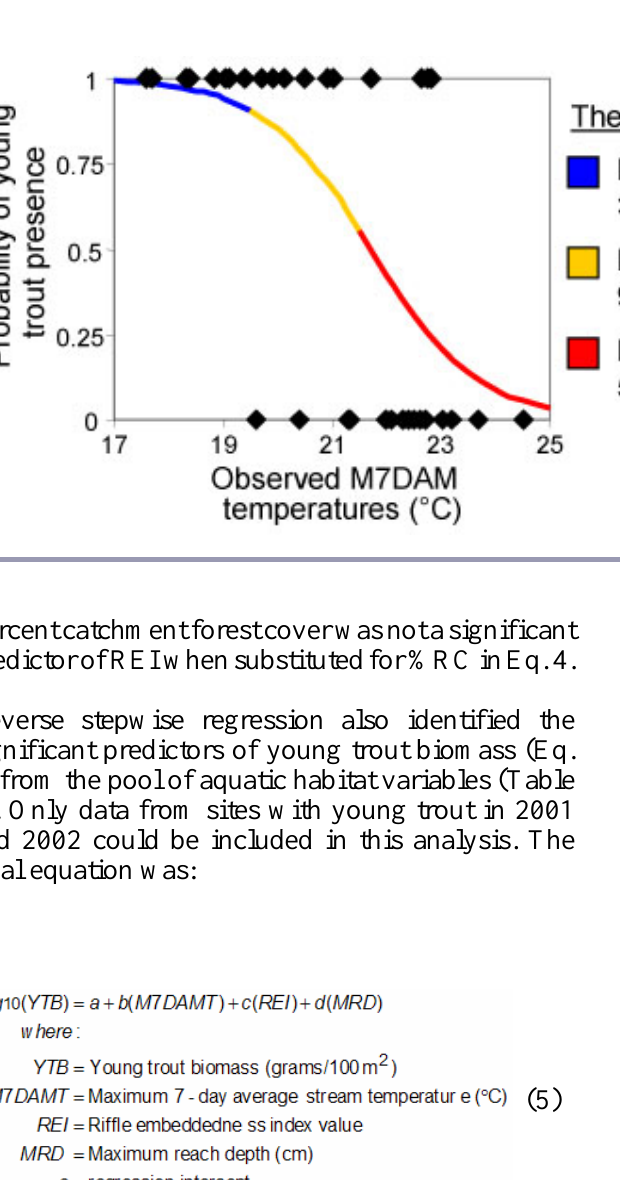
Fig. 8. Logistic model relating the probability of young trout presence to observed M7DAM stream temperatures (°C) for primary sites sampled for trout in 2001 and resampled in 2002 ( p <